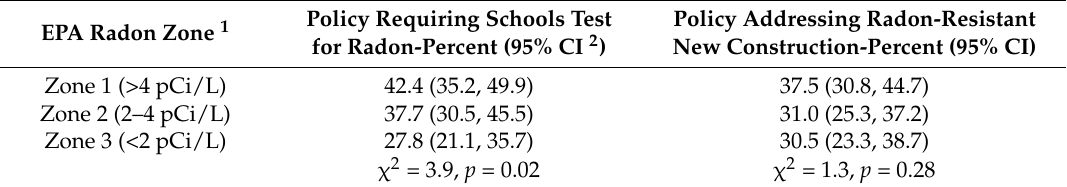
Table 1. Percentage of school districts with policies for radon testing and radon-resistant new construction practices by the Environmental Protection Agency (EPA) radon